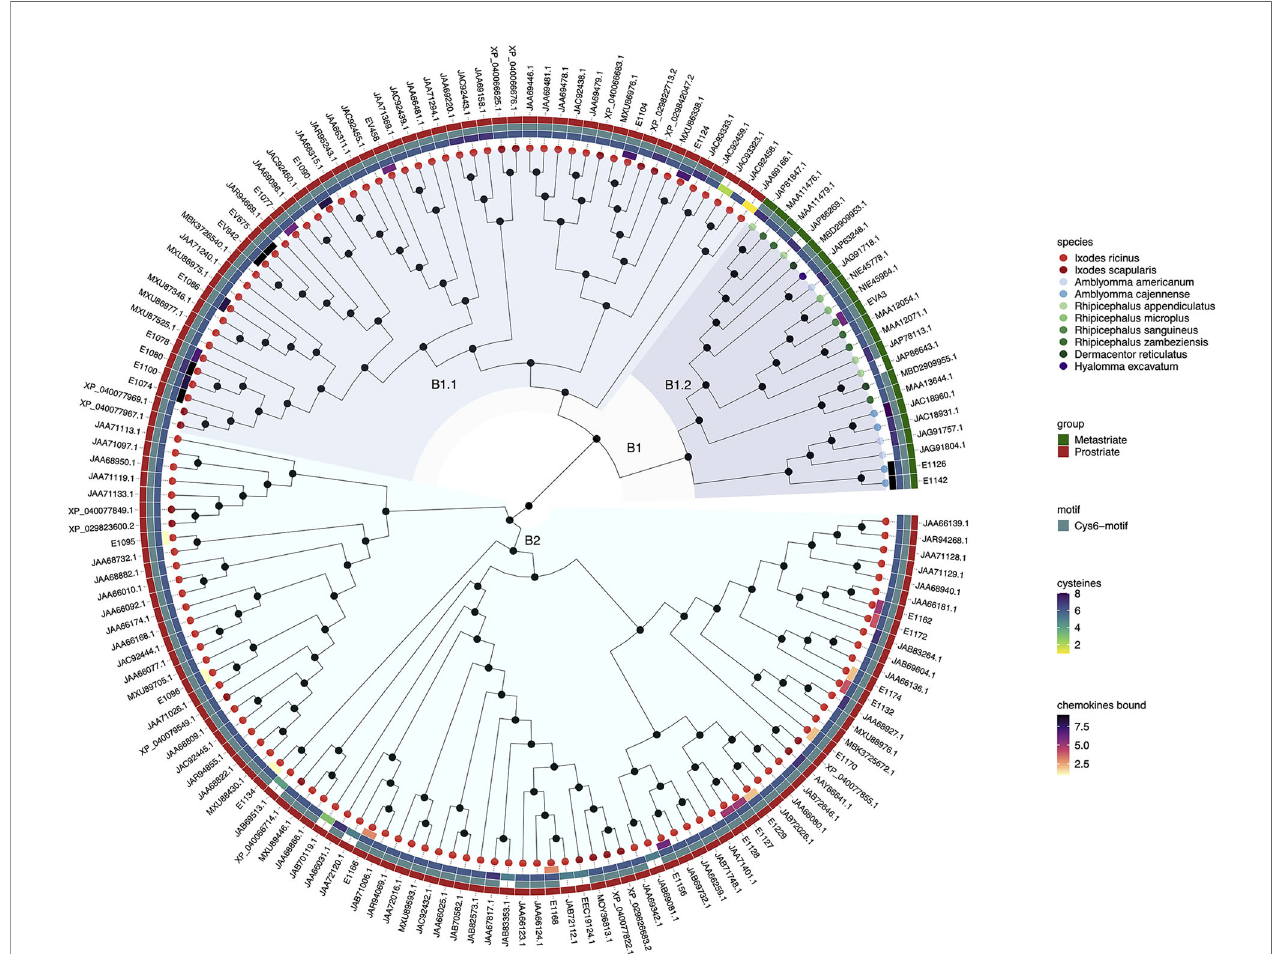
FIGURE 2 | Neighbour-joining tree of class B evasin and evasin-like proteins. Accession numbers of proteins are indicated at the tree tips, which are colour coded by species. The ancestral node at the centre was de fi ned by midpoint rooting. The outer circle of the heatmap indicates Prostriate or Metastriate lineage. The next two circles of the heatmap indicate the presence of a C-x(3)-C-x(6,10)-C-x(3,6)-C-x(1)-C-x(10,11)-C motif (Cys6-motif) and the numbers of cysteines respectively. The innermost circle of the heatmap indicates the number of CXC-chemokines bound by biochemically characterized evasins. Clades B1 and B2 were de fi ned as having diverged from the two nodes immediately following the ancestral node and are indicated in azure and cyan respectively. Subclades B1.1 and B1.2 were de fi ned as having diverged from the two nodes immediately following the node de fi ning clade B1 and are indicated in light and dark azure